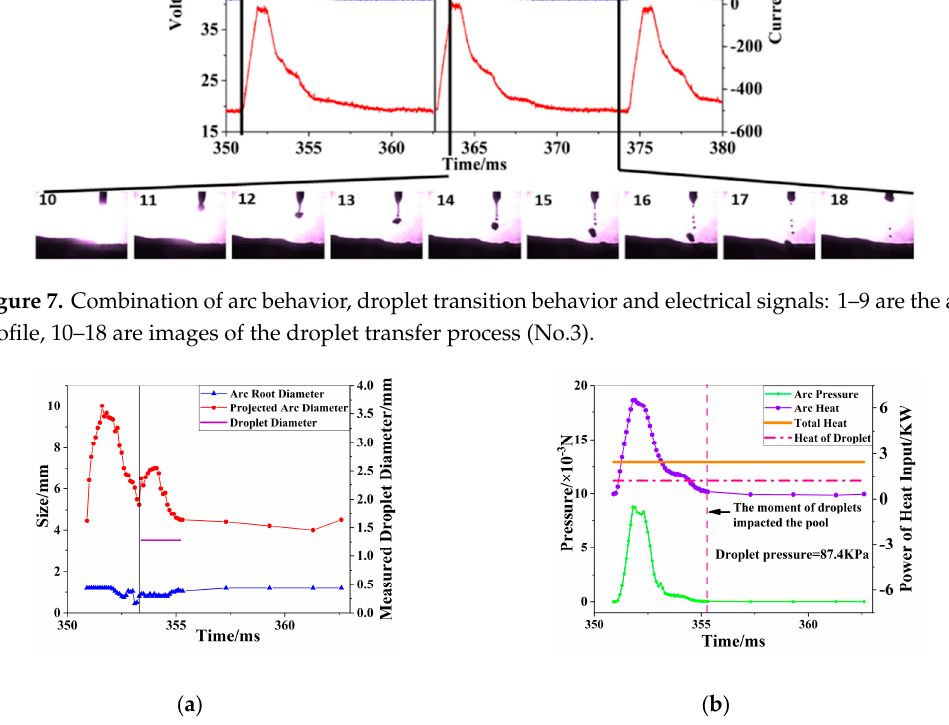
Figure 8. ( a ) Arc size and droplet diameter; ( b ) heat input and pressure acting on weld pool.